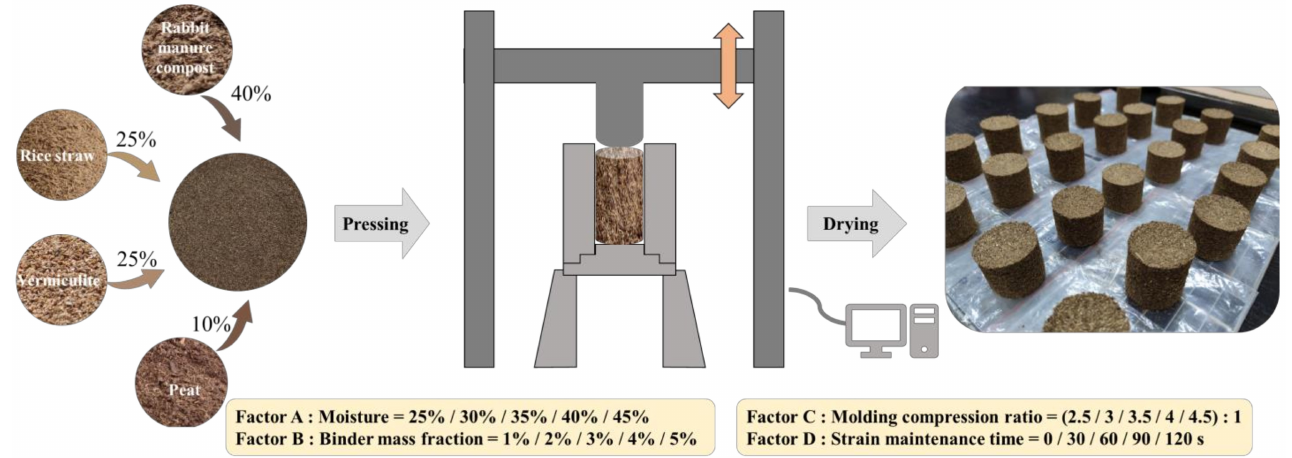
Figure 2. Technological process for forming rabbit manure compost seedling nursery